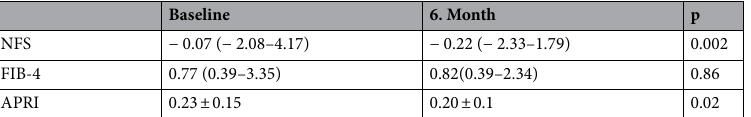
Table 2. Evaluation of fibrosis score of the patients before and after exenatide therapy. NFS NAFLD fibrosiz score, FIB-4 Fibrosis-4 index, APRI AST to Platelet Ratio Index.